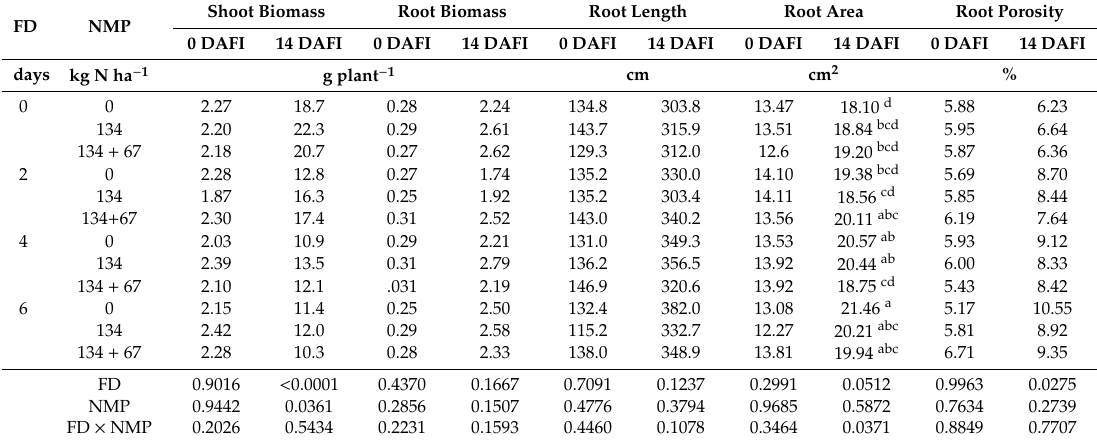
Table 3. Root length, area, and porosity for each flood duration (FD) and nitrogen management practice (NMP) 0, 7, and 14 days after flood initiation (DAFI). p values are presented within each column for FD, NMP, and FD × NMP. Di ff erent letters indicate di ff erences in means within each column and FD × NMP interaction.